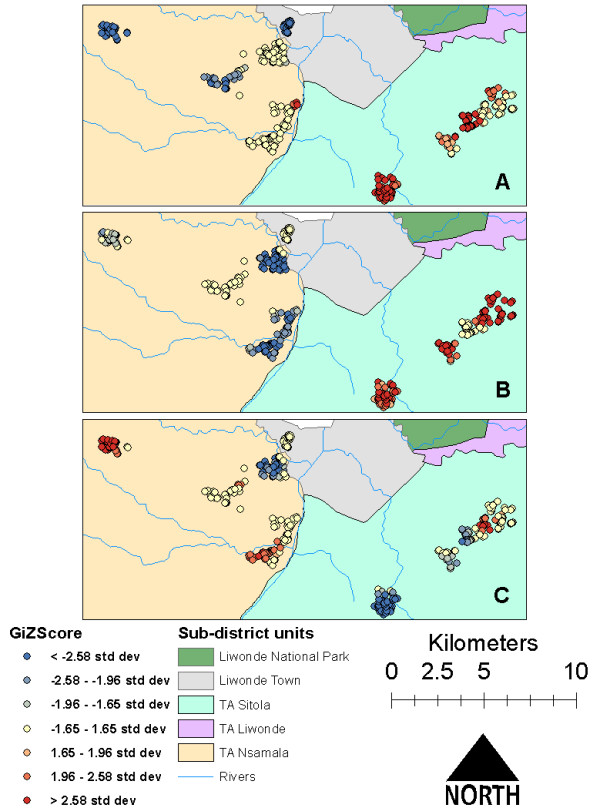
Univariate Gi* hotspots of A) malaria cases, B) houses <25 m from agriculture, and, C) bed net ownership in 390 households from ten villages near Liwonde, Malawi during June to August 2011.